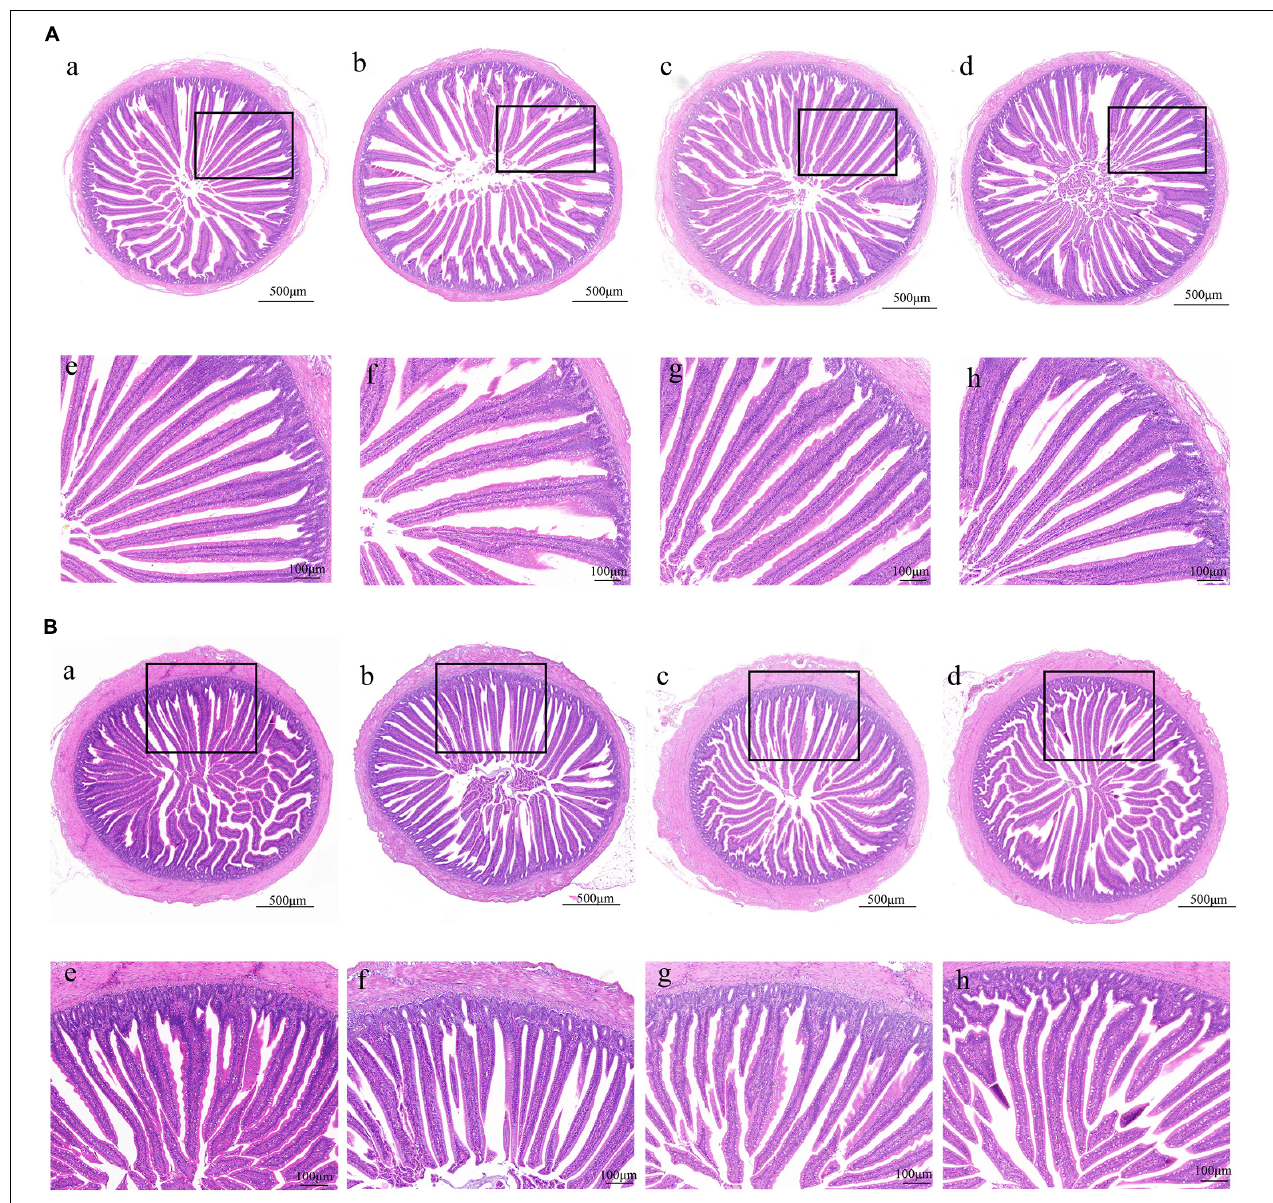
FIGURE 1 | Effect of phages on the morphology of the duodenum and jejunum in chicks. (A) H&E staining of duodenum in the NC, Phage 1, Phage 2, and AMX groups under 40 × (a-d) and 100 × (e-h) magnification. (B) H&E staining of jejunum under 40 × (a-d) and 100 × (e-h) magnification. NC, negative control; Phage